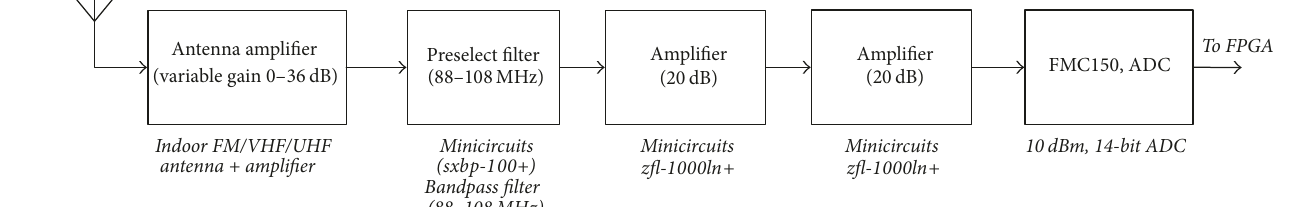
Antenna amplifier